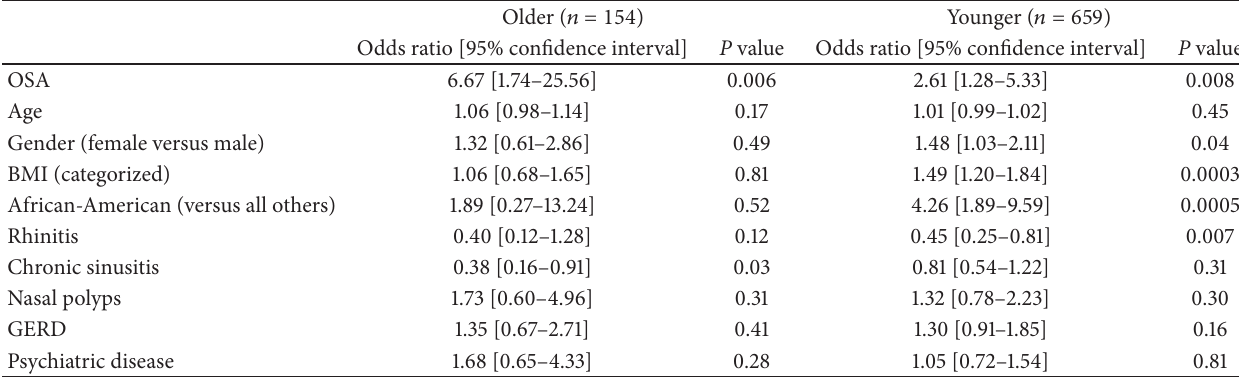
Table 7: Multivariate associations of severe asthma (step 3 or 4) with OSA (clinically-diagnosed and untreated) and other traditional factors of asthma control, in the older and younger asthma subjects.